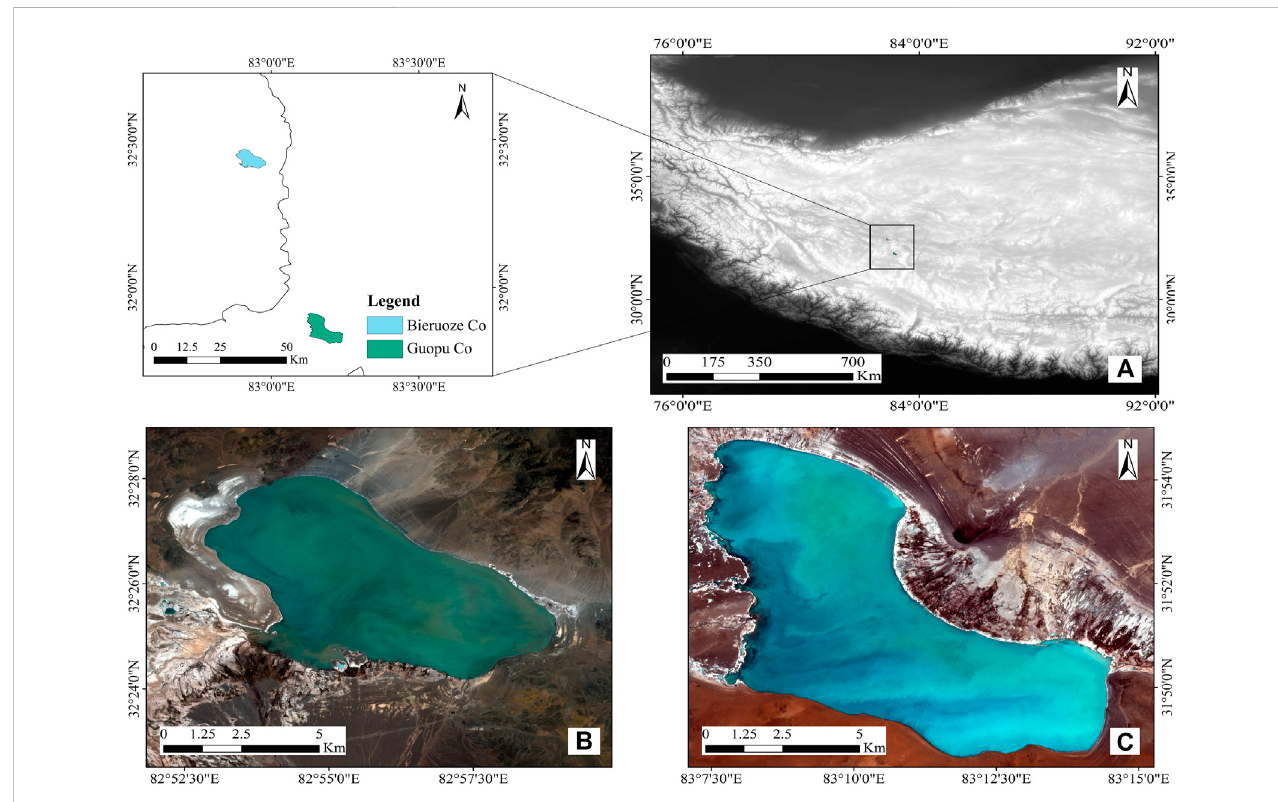
FIGURE 1 Locationoftheresearchregion. (A) TopographicmapoftheTP. (B) and (C) aretheSentinel-2imageryofBieruozeCoandGuopuCo,respectively,inMay